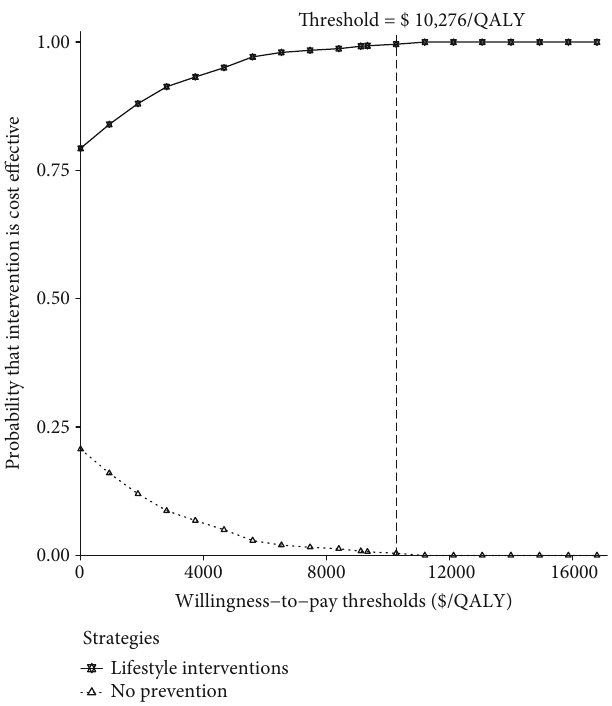
Figure 4: Cost-e ff ectiveness acceptability curve for lifestyle interventions versus no